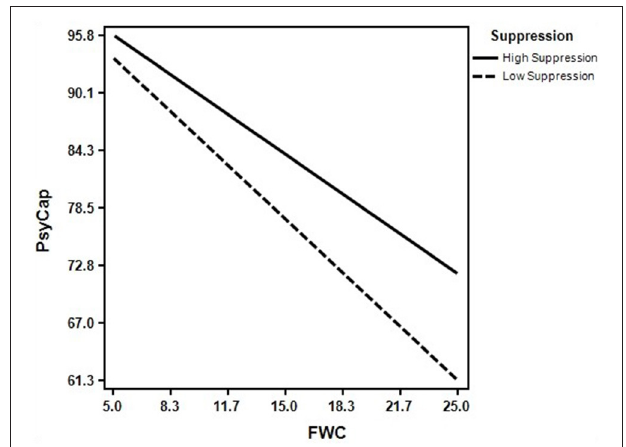
FIGURE 3 | The moderating effect of suppression on family-work conflict to positive psychological capital.